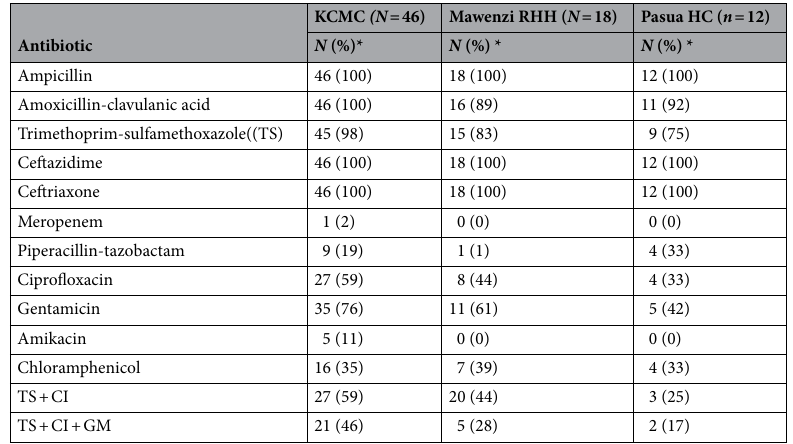
Table 2. Non-susceptibility against various antibiotics in ESBL-producing E. coli from 76 children detected in feces at admission in relation to level of care, i.e., zonal referral hospital (KCMC), regional referral hospital (Mawenzi RRH) and local health center (Pasua HC). *Percentage of non-susceptibility. TS trimethoprim- sulfamethoxazole, CI ciprofloxacin, GM gentamicin.